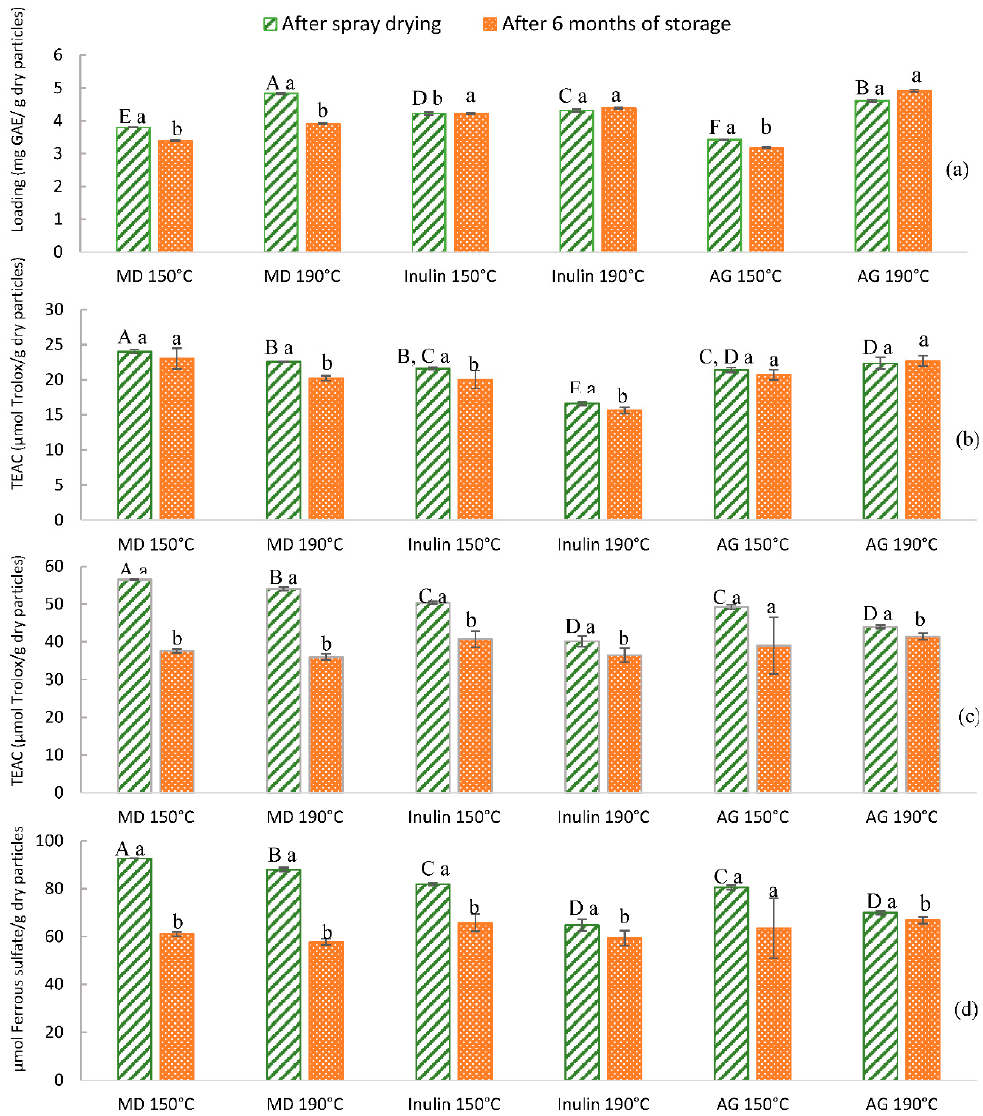
Figure 4. ( a ) Total phenol content of the microparticles produced, ( b ) antioxidant activity (AOA) of the encapsulated extract after spray drying by the 1,1–diphenyl-2-picrylhydrazyl (DPPH) method, ( c ) AOA by the ferric-reducing antioxidant power (FRAP) method expressed as Trolox equivalent antioxidant capacity (TEAC), and ( d ) AOA by the FRAP method expressed as µmol ferrous sulfate. Values are the mean of three different replicates. Different lower-case letters in the same double column show statistically significant differences among values for the same wall material and drying temperature ( p < 0.05). Different upper-case letters show statistically significant differences among values after spray drying ( p < 0.05). MD, maltodextrin and AG, arabic gum.